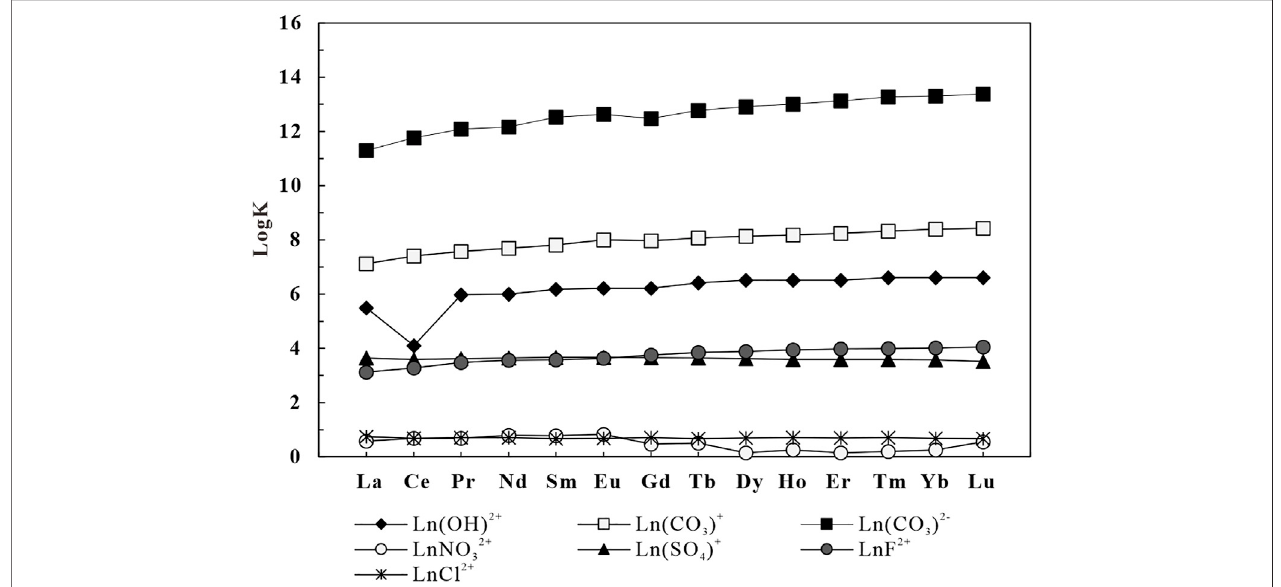
FIGURE12| VariationofcomplexationstabilityconstantsofdifferentcomplexesofrareEarthelementswithincreasingelementalorder(temperature25 ° C)(Leeand Byrne, 1992; Millero, 1992; Luo and Byrne, 2001, 2004; Schijf and Byrne, 2004).